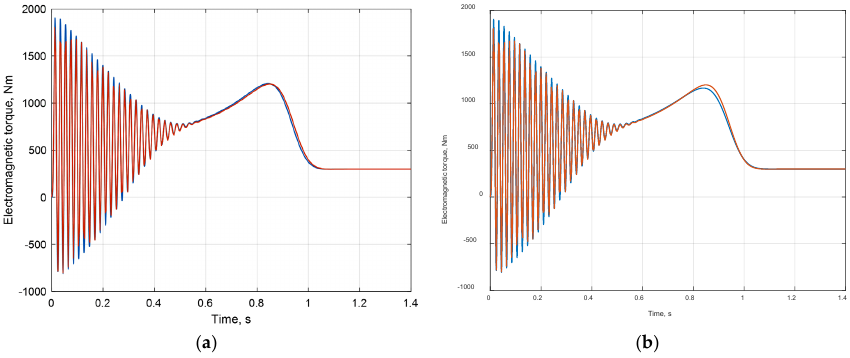
Figure 11. Calculated electromagnetic torque of IM: AVIS method of the 1st order (blue) ( a ), AVIS method of the 2nd order (blue) ( b ), and etalon result (red).